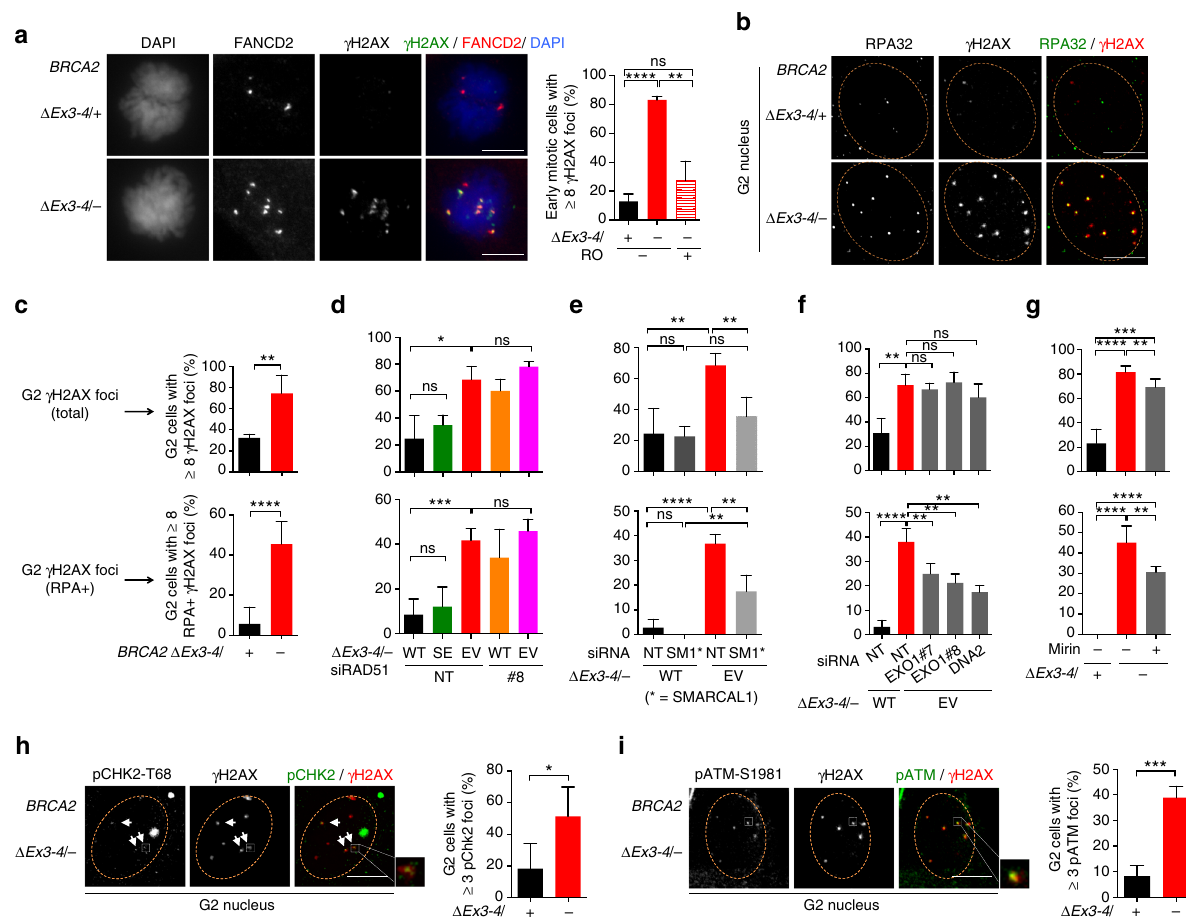
Fig. 8 BRCA2-de fi cient cells accumulate single-stranded DNA lesions in G2. a γ H2AX foci analysis in early mitotic cells. Cells were untreated, or treated with RO-3306 (10 µ M, 24 h) to delay mitotic entry, and released for 1 h before analysis of γ H2AX and FANCD2 foci pairs in early mitotic cells. Representative images are shown ( left ). Analysis is by an unpaired two-tailed t -test. n = 3. Scale bars 10 µ m. b – g Cells treated with the indicated siRNAs or mirin (50 µ M, 5 h) were incubated with EdU for 30 min and then analyzed for γ H2AX and RPA foci in G2 cells (EdU – , 2N DNA content). Representative deconvolved images are shown ( b ). Quanti fi cation of γ H2AX foci ( top , c – g ) and RPA+ γ H2AX foci ( bottom , c – g ) for BRCA2-de fi cient cells ( c ), cells transfected with siRNAs ( d , RAD51; e SMARCAL1; f EXO1 and DNA2), and cells treated with mirin ( g ) are shown. n ≥ 3. Scale bars 10 µ m. h , i Cells were incubated with EdU as in b before analysis of γ H2AX and pCHK2-T68 ( h ) or pATM-S1981 ( i ) foci in G2 cells. Representative deconvolved images with magni fi ed inset highlighting foci co-localization are shown ( left in each panel). n ≥ 3. Scale bars 10 µ m. Error bars s.d. ns, not signi fi cant; * p < 0.05; ** p < 0.01; *** p < 0.001; **** p < 0.0001 (unpaired two-tailed t